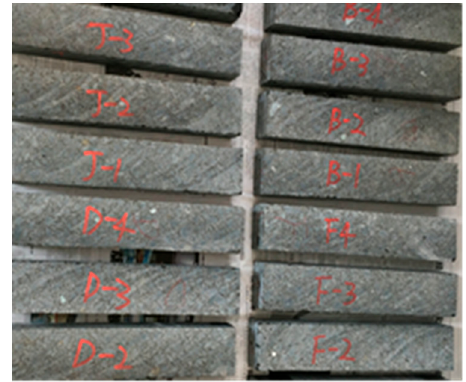
Figure 7. Samples of Four-point Bending Fatigue test.